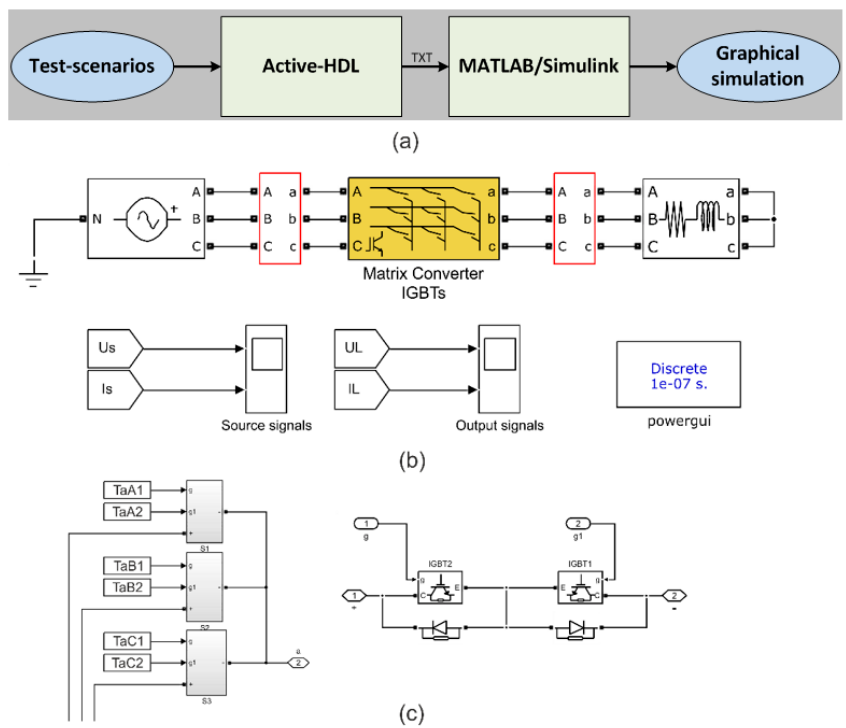
Figure 7. Software verification of the system: ( a ) the procedure; ( b ) MATLAB / Simulink main simulation program; ( c ) schematic diagram of one output phase of MC placed in “Matrix Converter insulated gate bipolar transistors (IGBTs)” subsystems and bi-directional IGBT switches.